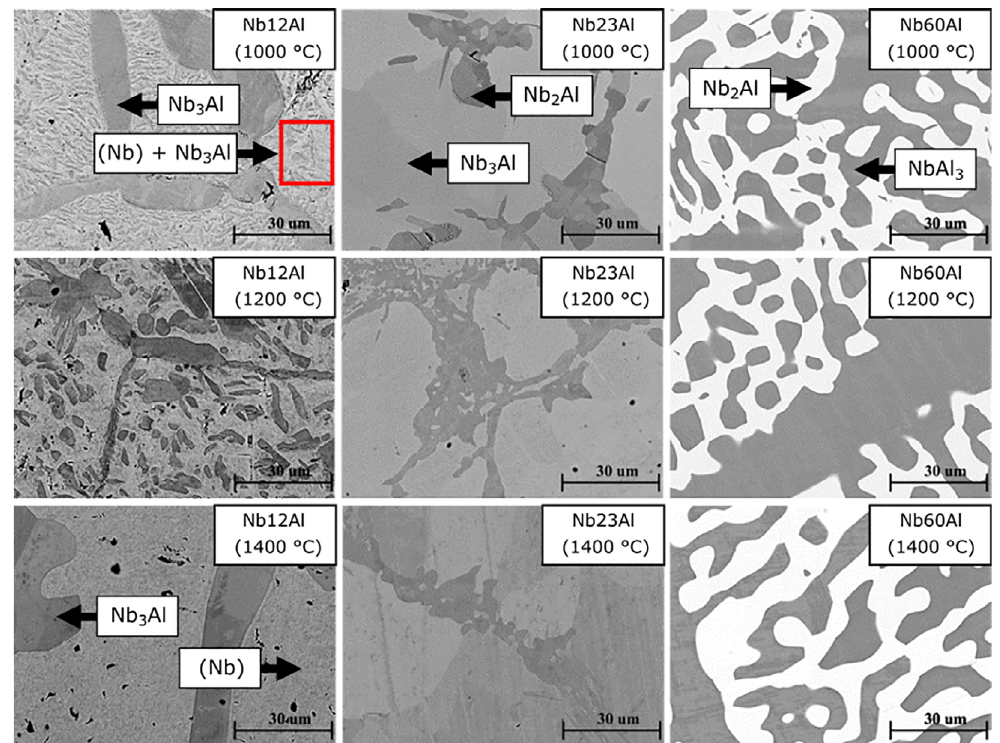
Figure 2. Evolution of the microstructure of the Alloys Nb12Al, Nb23Al and Nb60Al equilibrated at 1000, 1200 and 1400 °C.